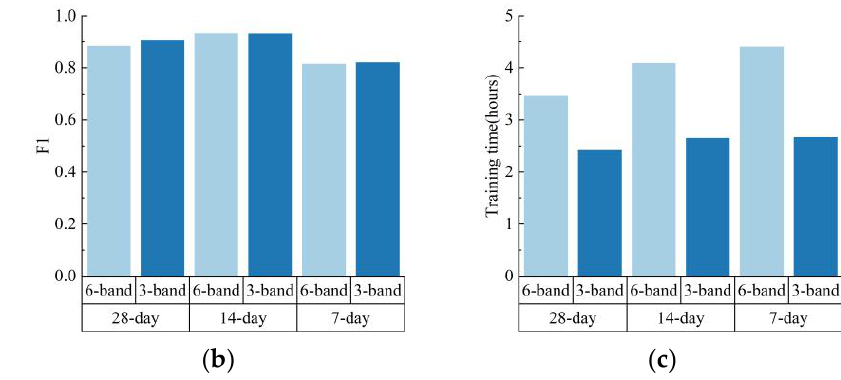
Figure 7. The effect of band selection on the extraction accuracy. The 3-band combination includes red band, near-infrared band, and Swir-1 band. The 6-band combination includes red, green, blue, near-infrared, and two Swir bands. ( a ) Overall accuracy; ( b ) F1 scores; ( c ) Training time.